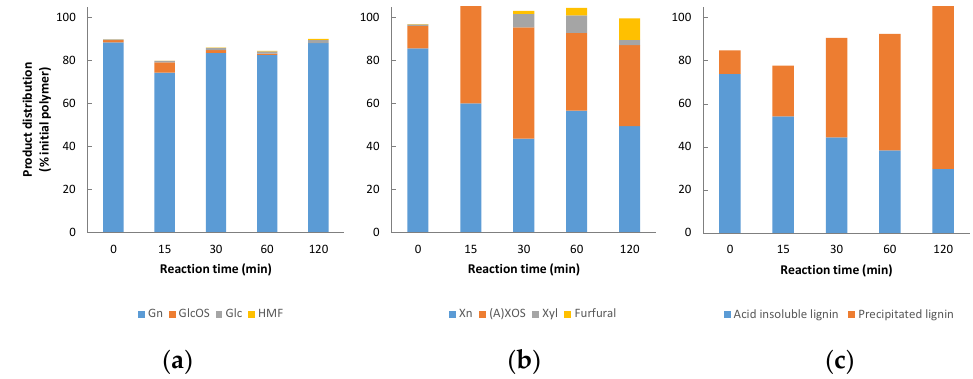
Figure 3. Product distribution obtained for eucalyptus residues (ERs) using ethanol-based organosolv fractionation (no catalyst added) for glucan ( a ), (arabino)xylan ( b ) and lignin ( c ). Abbreviations are as in caption of Figure 2. Table 2. Fractionation of wheat straw (WS) and eucalyptus residues (ERs) biomass using ethanol- based organosolv process (no added catalyst, 190 °C).